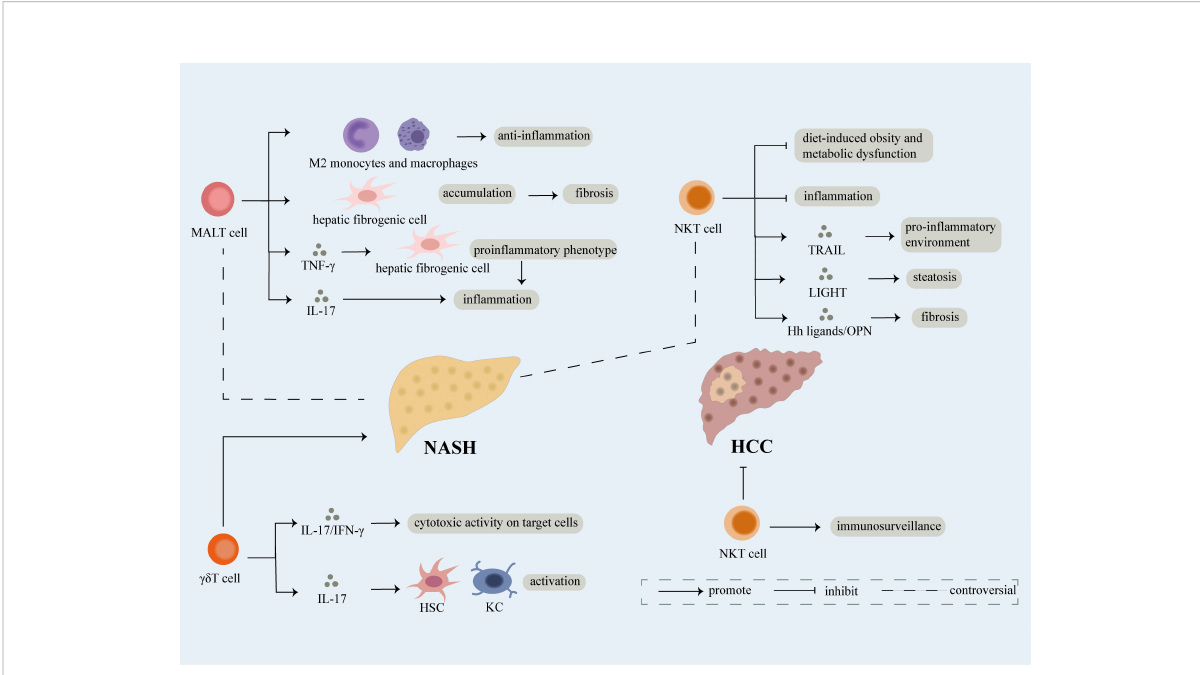
FIGURE 3 Role of unconventional T cell. Unconventional T cells like NKT, MALT, gd T cells participate in the development of NAFLD. gd T cells have been proven to facilitate the development of NAFLD through secretion of IL-17 and IFN- g which can lead to cytotoxic activity on target cells. What ’ s more, IL-17 released by gd T cells can induce activation of hepatic stellate cells (HSCs) and KCs thus promoting fi brosis in NASH. However, con fl icting results regarding the role of NKT and MALT cells in NAFLD have been exhibit. NKT cells have been reported as protective factors of NASH, mechanically, they can not only restrain diet-induced obesity and metabolic dysfunction but also limit in fl ammation. However, NKT cells can induce pro-in fl ammatory environment and steatosis dependent of TRAIL and LIGHT respectively. Meanwhile, fi brosis is accelerated partly attributed to release of Hh ligands/OPN by NKT cells. On one hand, MALT cells induce the differentiation of monocytes and macrophages into anti-in fl ammatory phenotype thus inhibiting development of NASH. On the other hand, MALT cells can not only induce the accumulation of hepatic fi brogenic cells which further result in fi brosis, but also promote in fl ammation through differentiation of hepatic fi brogenic cells into pro-in fl ammatory phenotype dependent of TNF- g and release of IL-17. Last but not the least, NKT cells functioning as immune surveillance cells are crucial in suppressing NASH-induced